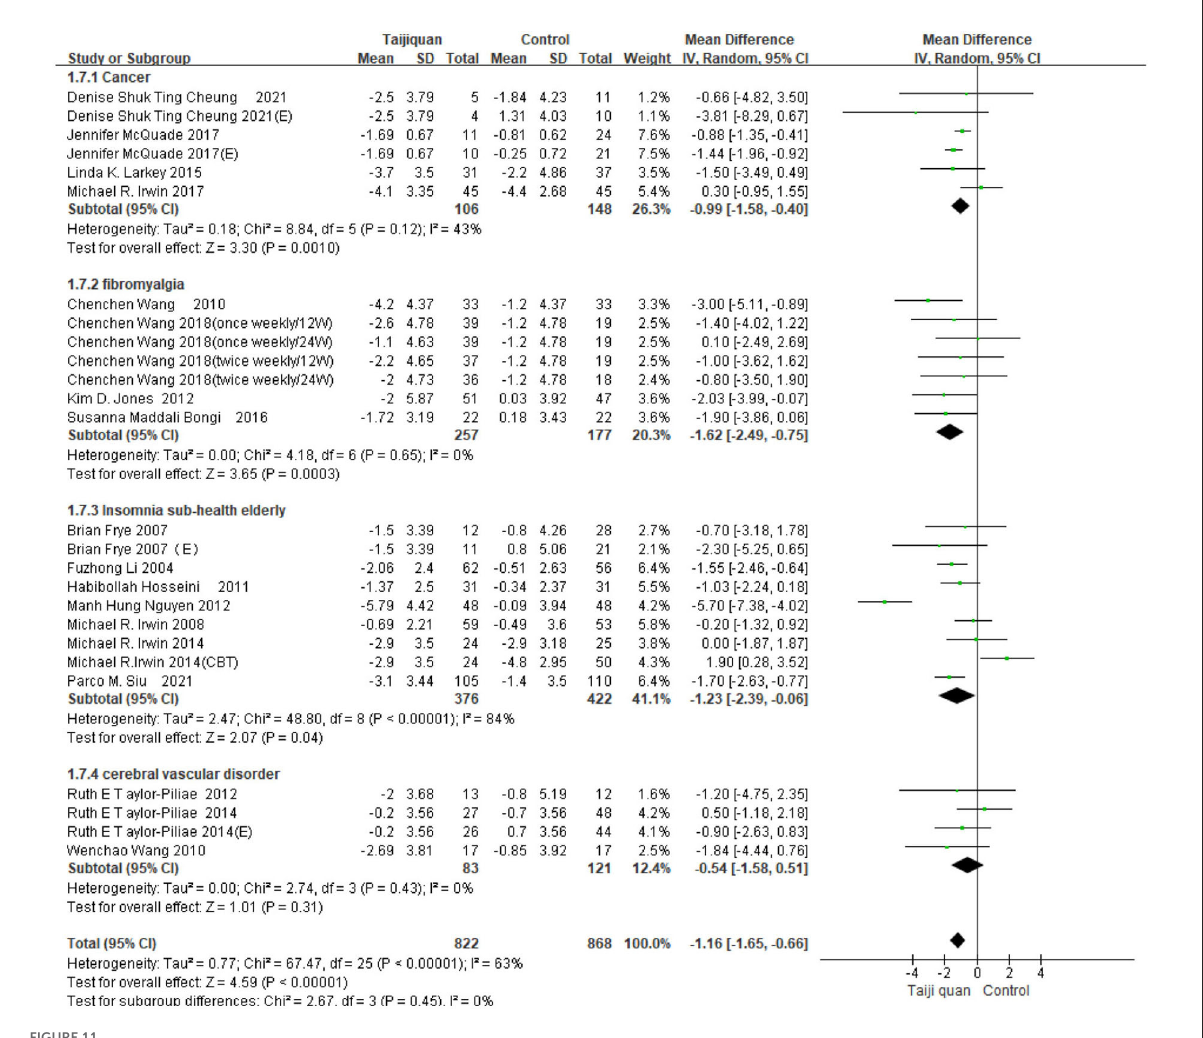
FIGURE11 Subgroups of different patients analyzed forest